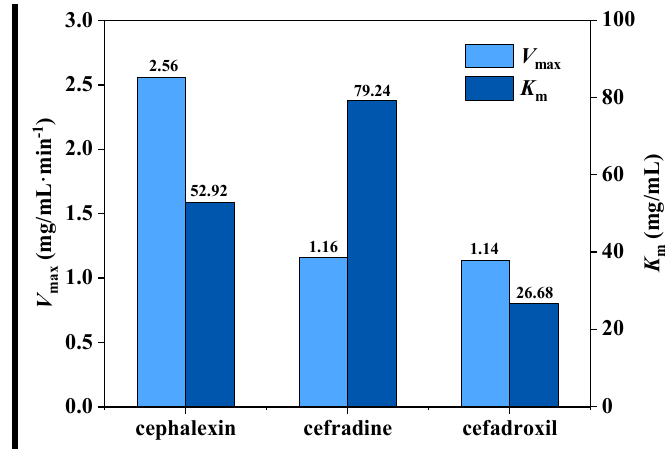
Figure 6. Corresponding V max and K m of cephalexin, cefradin, and cefadroxil.